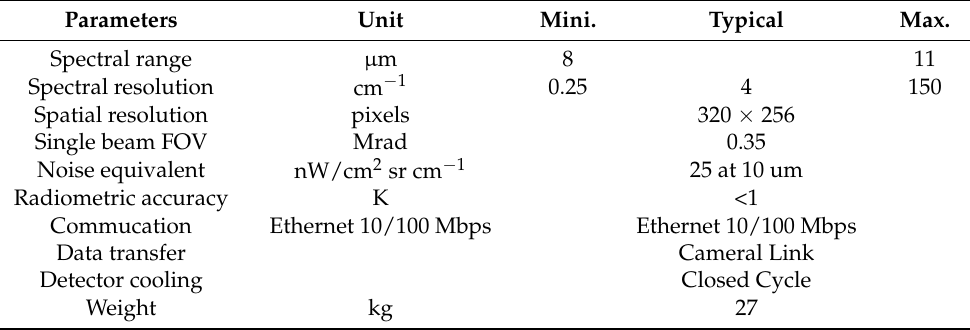
Table 2. Technical parameters of